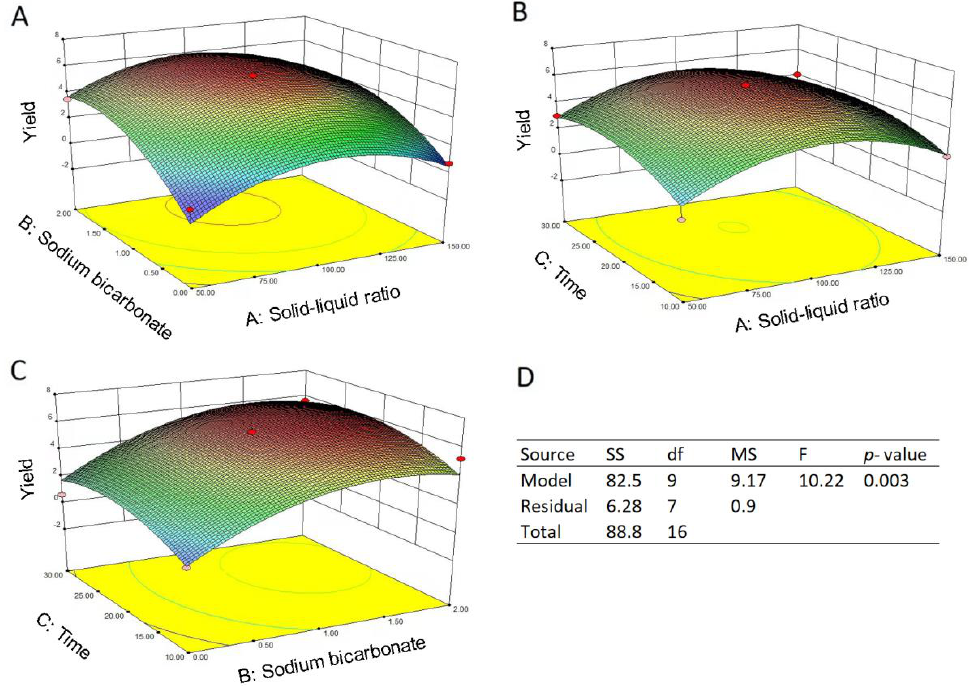
Figure 4. Response surface plots and ANOVA table for the quadratic model. ( A – C ) response surface plots refer to the NaHCO 3 concentration, S/L ratio, time and their mutual effects on the extraction yield of ellagic acid; ( D ) ANOVA results for the quadratic